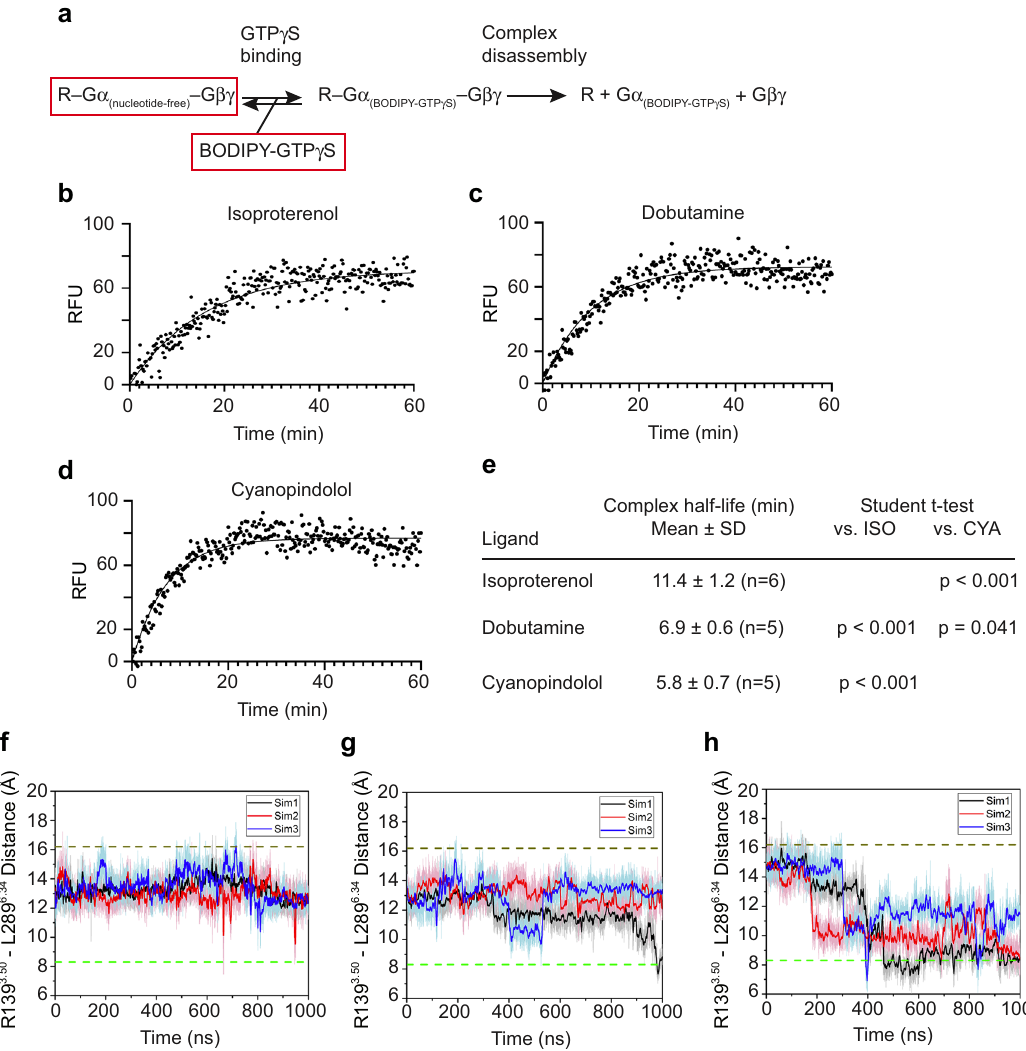
Fig. 7 Biochemical studies and GaMD simulations of the stability of the complexes of β 1 -AR and Gs when bound with a full agonist, a partial agonist, or a very weak partial agonist. a A schematic diagram represents the chemical process from BODIPY-GTP γ S binding to the complex of ligand – receptor – G α (nucleotide-free) – G βγ ), leading to the formation of the transient R – G(BODIPY-GTP γ S) bound complex and the subsequent complex disassembly. b – e BODIPY-GTP γ S binding to the transition state complex in the presence of isoproterenol ( b ), dobutamine ( c ), or cyanopindolol ( d ). Units reported as relative fl uorescent units (RFU). One representative experiment from fi ve or six independent experiments with similar results is shown for each case. e Summary of the half-life values. Data are shown as mean ± SD of fi ve or six independent experiments. Two-sided P values are from Student ’ s t -test. f – h Ligand-dependent structural dynamics of β 1 -AR in the absence of Gs. The distance between the cytoplasmic ends of TM3 and TM6 (measured as the distance between the C α atoms of Arg139 3.50 and Leu289 6.34 ) is calculated over the indicated time. Three GaMD simulations (black, red, blue) were performed. Lines depict the running average over 2 ns. The top dash lines indicate the distance observed in the cryo-EM structures, and the bottom dash lines indicate the distance observed in the inactive β 1 -AR (PDB buffer. Puri fi ed membranes were resuspended in 20 mM Tris, pH 8, 0.2 mM isoproterenol, and 200 mM imidazole. The elution was concentrated and further EDTA, and protease inhibitor cocktail and fl ash frozen in liquid nitrogen and puri fi ed by size-exclusion chromatography using a Superdex 200 Increase 10/300 stored at − 80°C. For protein puri fi cation, membrane preparations were fi rst column (GE Healthcare) pre-equilibrated with 20mM Tris, pH 8, 150 mM NaCl, thawed in 20 mM Tris, pH 8, 350 mM NaCl, and protease inhibitor cocktail. 1 mM 0.02% Lauryl Maltose Neopentyl Glycol (LMNG, Anatrace), 1 mM isoproterenol. isoproterenol (Sigma) was then added and the mixture was stirred for 1h at 4°C Dobutamine- and cyanopindolol-bound β 1 -AR proteins were puri fi ed using the and the membranes were then solubilized in 20mM Tris, pH 8, 350 mM NaCl, 1% same protocol with 200µM dobutamine and 50µM cyanopindolol present during n-Dodecyl- β -D-Maltopyranoside (DDM, Anatrace), 1 mM isoproterenol and puri fi cation. Puri fi ed β 1 -AR was concentrated to 4mg/ml and either used imme- protease inhibitor cocktail for 1 hr at 4 °C. The DDM concentration was then diately for complex assembly or fl ash frozen in liquid nitrogen and stored at reduced to 0.5% by adding equal volume of 20 mM Tris, pH 8, 350 mM NaCl, and 1mM isoproterenol and the mixture was stirred for another 1hr at 4°C. The preparation was clari fi ed by ultracentrifugation at 142,000 g for 30min at 8 °C. The supernatant was then incubated with Ni-NTA resin (Qiagen) with stirring at 4°C with 8 mM imidazole. After 4 hrs, the resin was collected by centrifugation and washed three times with 20mM Tris, pH 8, 500 mM NaCl, 0.05% DDM, 1mM isoproterenol, and 20 mM imidazole and one time with 20mM Tris, pH 8, 150 mM NaCl, 0.05% DDM, 1mM isoproterenol, and 20 mM imidazole. β 1 -AR was then eluted from the resin with 20mM Tris, pH 8, 150 mM NaCl, 0.05% DDM, 1 mM